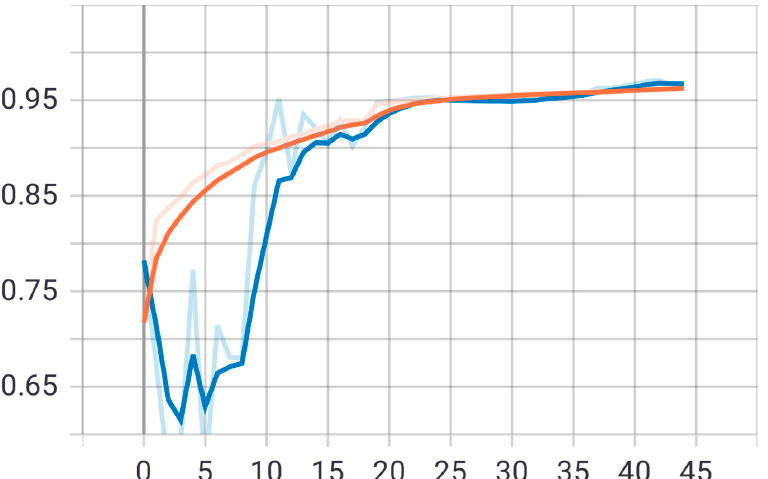
Figure 14. Accuracy (red line) and validation (blue line) converge curves of the second model over 45 epochs.